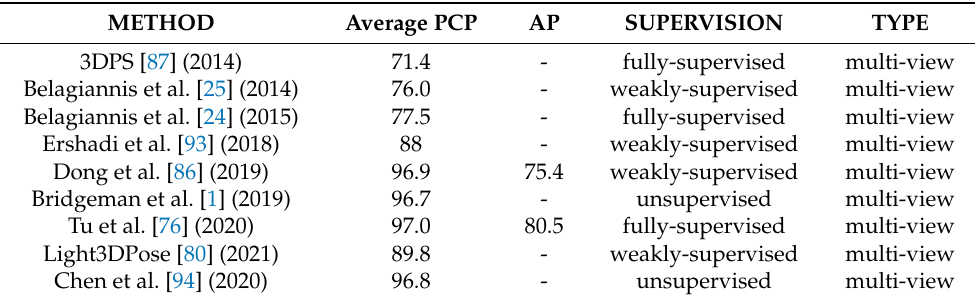
Table 6. Summary of the state-of-the-art multi-person 3D pose estimation methods on Shelf dataset. ‘-’ means no published